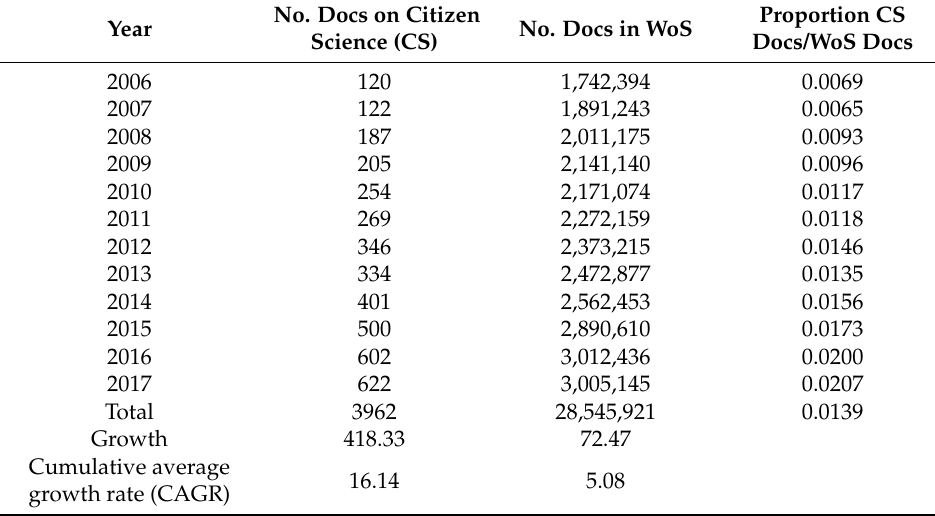
Figure 1. Yearly variation in the output on citizen science. Table 1. Yearly variation in output on citizen science, growth rate and proportion of publications on citizen science in the Web of Science (WoS) database (2006–2017).